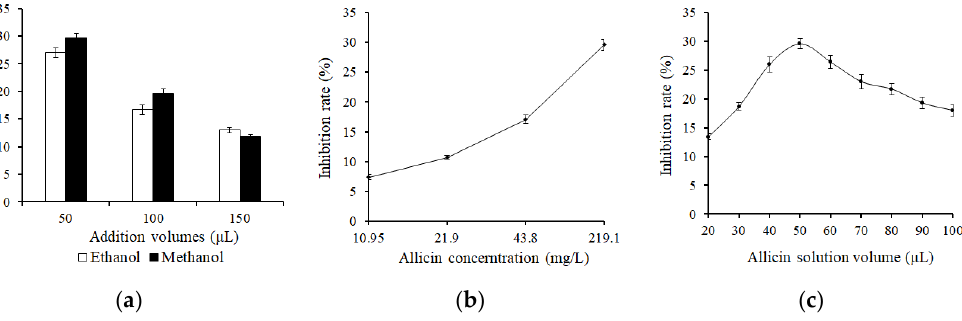
Figure 5. Reducing effect of allicin on acrylamide content of Glc/Asn solution system. ( a ) Effect of reconstitution solvents of allicin on acrylamide inhibition rate; ( b ) Effect of allicin concentration on acrylamide inhibition rate; ( c ) Effect of allicin addition volumes on acrylamide inhibition rate.